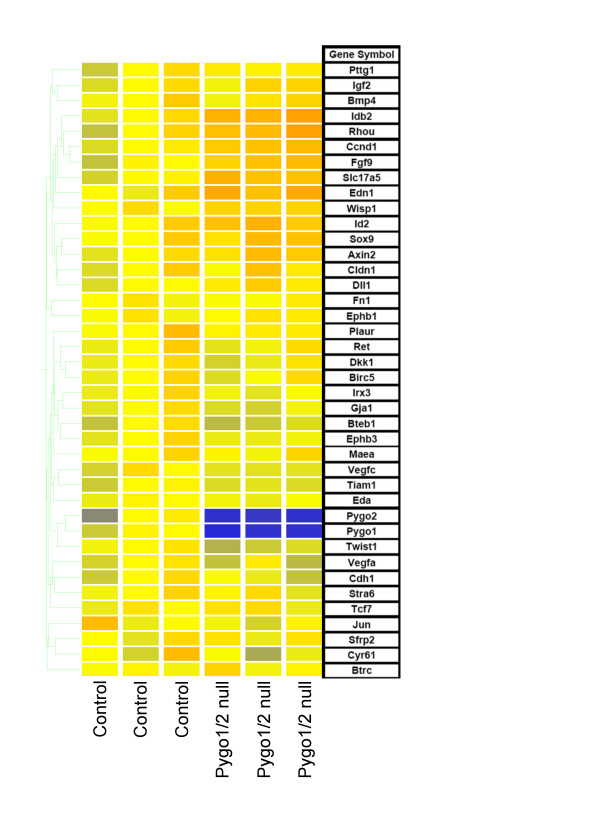
Gene expression changes of common Wnt signaling targets in the E18.5 Pygo1/Pygo2 null kidney. Microarray analysis was performed in triplicate on wild-type and Pygo1/2 compound null E18.5 kidneys. Possible Wnt targets were selected from those compiled at [39]. An initial gene list of 82 Wnt targets was created and then reduced to a total of 40 genes using an expression level restriction requiring the raw expression intensity to be >100 in at least 3 samples. Pygo1 and Pygo2 probes were included to demonstrate significant changes in expression levels.